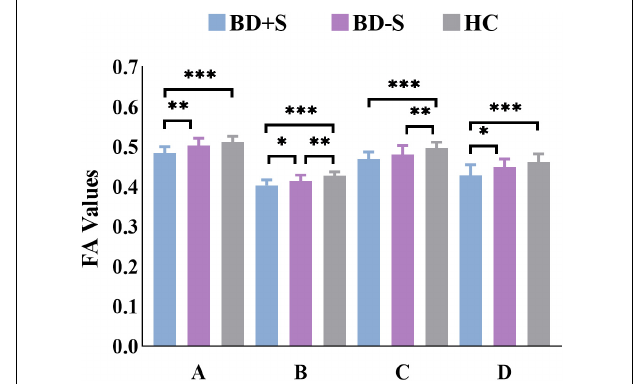
FIGURE 3 | FA values of each cluster in the BD + S, BD-S, and HC groups. A, the left middle cerebellar peduncle; B, the right middle cerebellar peduncle; C, the bilateral body and genu of corpus callosum; D, the left superior corona radiate. ∗∗∗ p < 0.001; ∗∗ p < 0.01; ∗ p <